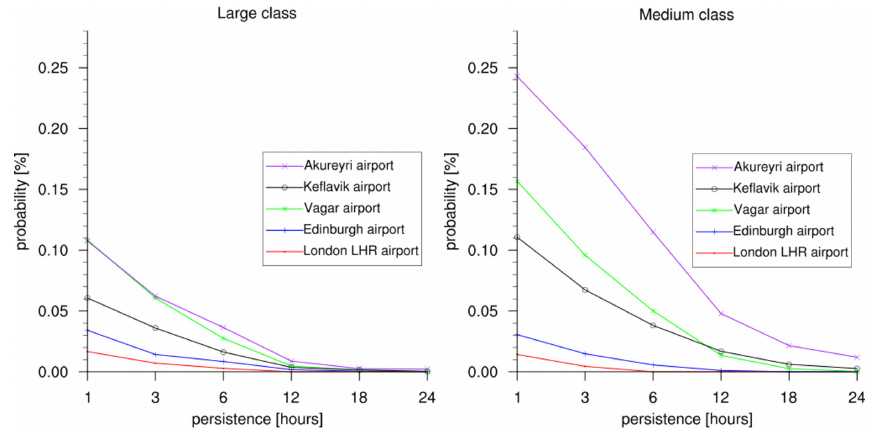
Figure 15. Persistence analysis for ash concentration of up to 2mgm − 3 at FL050. Exceedance probability of reaching or exceeding ash concentration above 2mgm − 3 at FL050 at 1, 3, 6, 12, 18, and 24h at different airports during the eruption to up to 48h after its end.